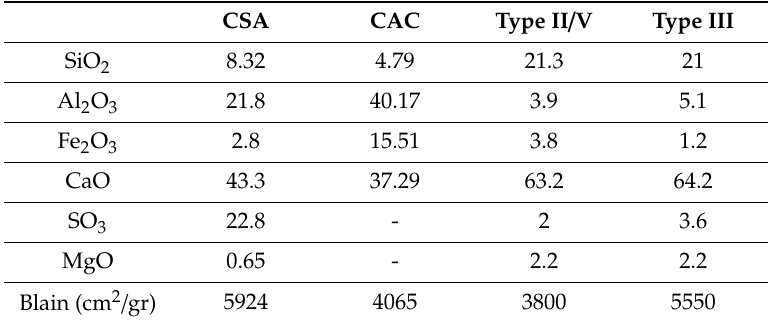
Table 1. Oxide composition of cementitious